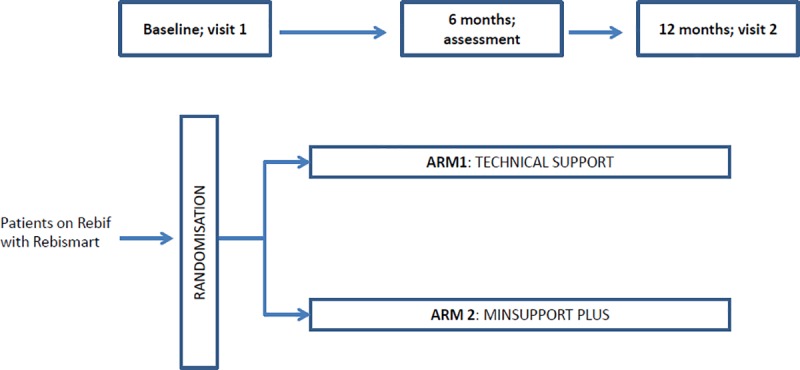
Trial design.Patients on Rebif using Rebismart were randomized to the two treatment arms at the Baseline visit. The study contained two additional assessment timepoints, at 6 and 12 months post baseline, where patients were assessed in accordance with the protocol (S1 File).